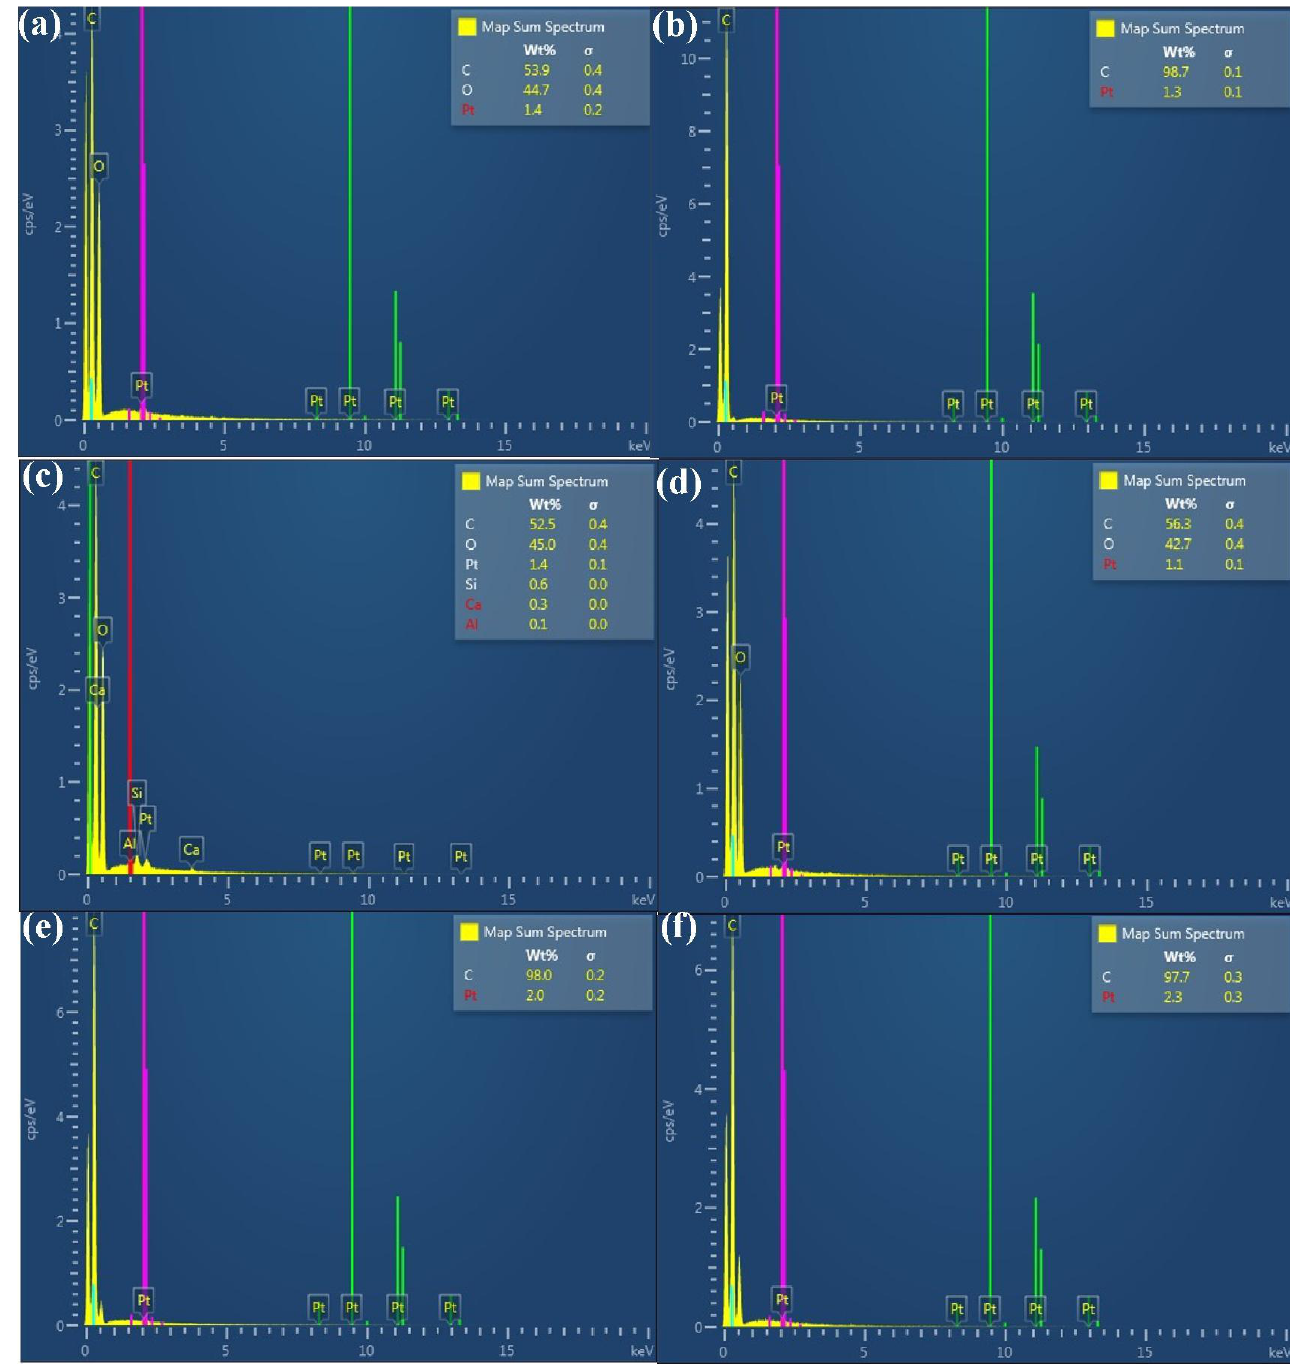
Figure 14. EDS analysis of ( a ) PLA, ( b ) ABS, ( c ) 10 wt.% glass fiber-reinforced PLA, ( d ) 10 wt.% carbon fiber-reinforced PLA, ( e ) PA, and ( f ) PC filaments.